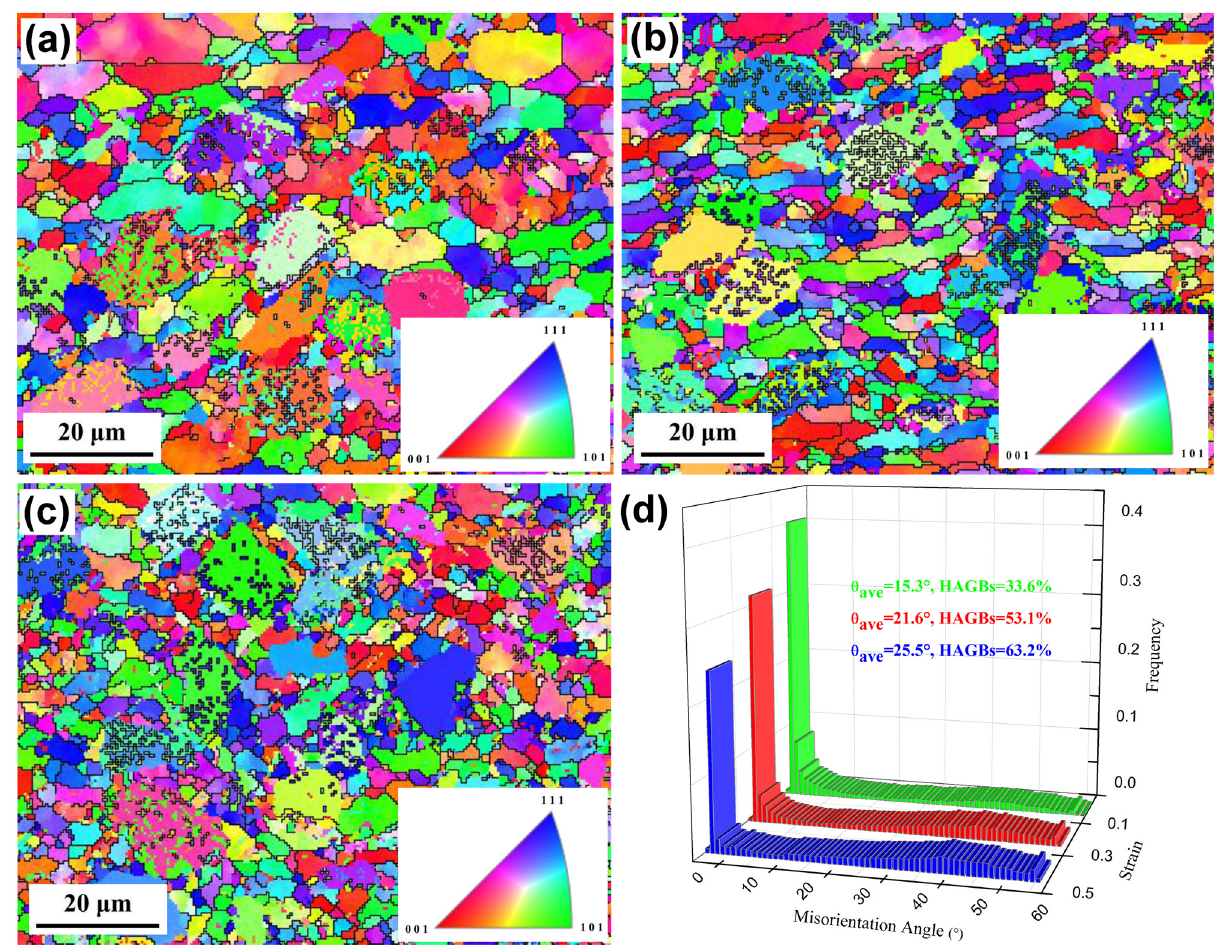
Figure 14: IPF maps and misorientation angle distributions of HAMCs at 500°C with a strain rate of 1 s − 1 and strains of ( a ) 0.1, ( b ) 0.3, ( c ) 0.5, and ( d ) misorientation angle distributions in ( a – c )